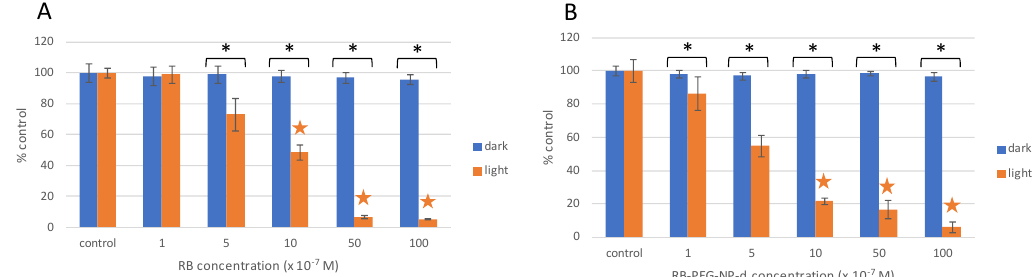
Figure 4. Cell viability (MTT assay) of HeLa cells exposed to different RB concentrations, ( A ) in solution, and ( B ) tethered at MNS (sample RB-PEG-NP- d ) under dark conditions (blue bars) and green irradiation at 518 nm and 10 J/cm 2 (orange bars). Stars indicate significant differences with respect to controls. Asterisks indicate significant differences between dark and light conditions at the same concentrations tested.